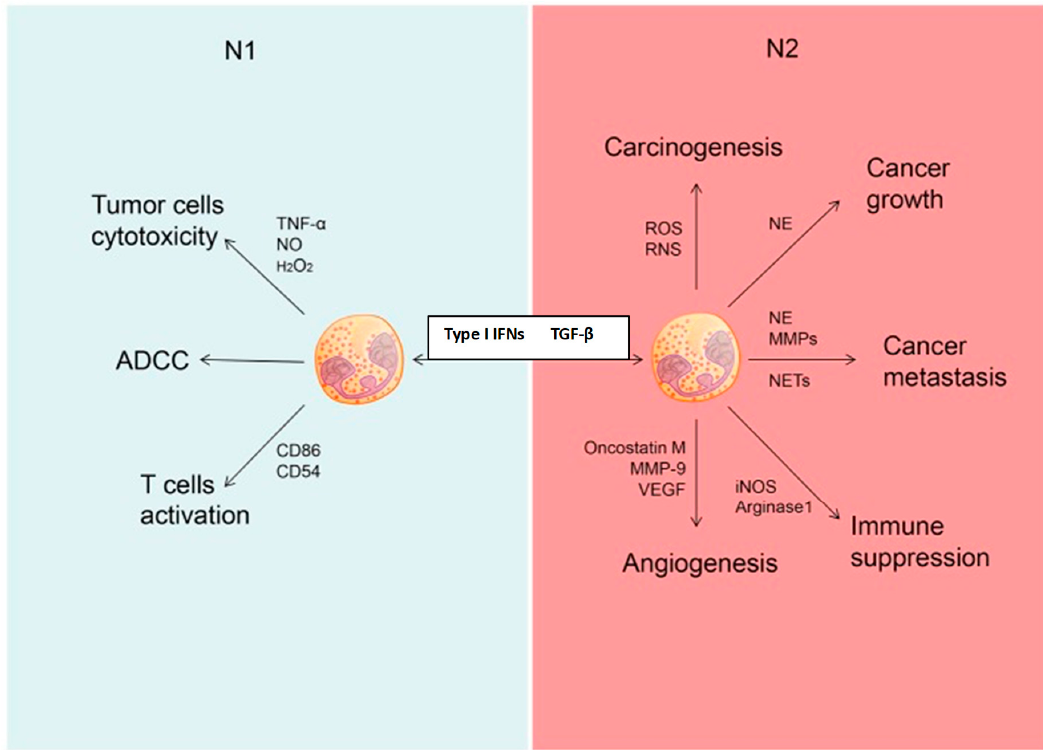
Figure 3. Different roles of N1 and N2 neutrophils in cancer. Neutrophils could be polarized into N1 phenotype under the induction of type I interferon (IFNs) and polarized into N2 phenotype under the induction of transforming growth factor- β 1 (TGF- β 1). N1 neutrophils may inhibit the development of cancer through tumor cell cytotoxicity, antibody-dependent cell-mediated cytotoxicity (ADCC), as well as activation of T cells. N2 neutrophils may promote carcinogenesis, tumor growth, metastasis, and angiogenesis, as well as immunosuppression. N0: Nitric oxide; H 2 O 2 : Hydrogen peroxide; CD86 and CD 54: Co-stimulatory molecules; ROS: Reactive oxygen species; RNS: Reactive nitrogen species; MMP: Matrix metalloproteinase; VEGF: Vascular endothelial growth factor; NE: Neutrophil elastase; NETs: Neutrophil extracellular traps; iNOS: Inducible nitric oxide synthase. Reproduced with the approval of the authors with minor modifications: Wang; Qiu; Li; Wang; Yi. “Understanding the multifaceted role of neutrophils in cancer and autoimmune diseases.” Front. Immunol. 2018 , 9 , 2456, doi:10.3389/fimmu.2018.02456. PMID: 30473691 (Reference [72] in the